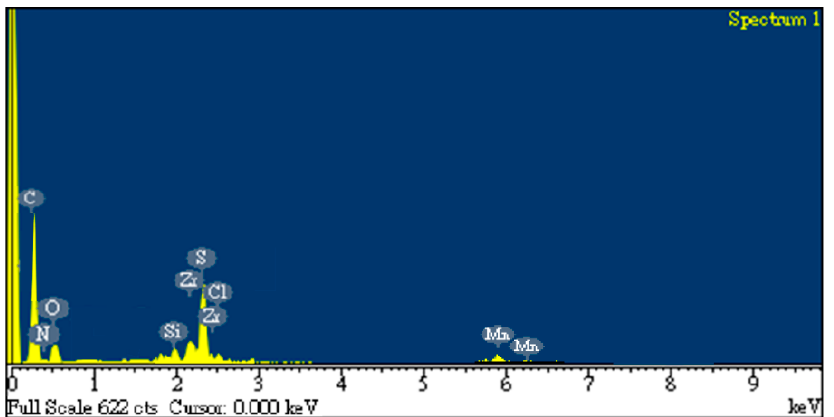
Figure 5. EDS mapping of the rGO/DPP2T-TT composite film.